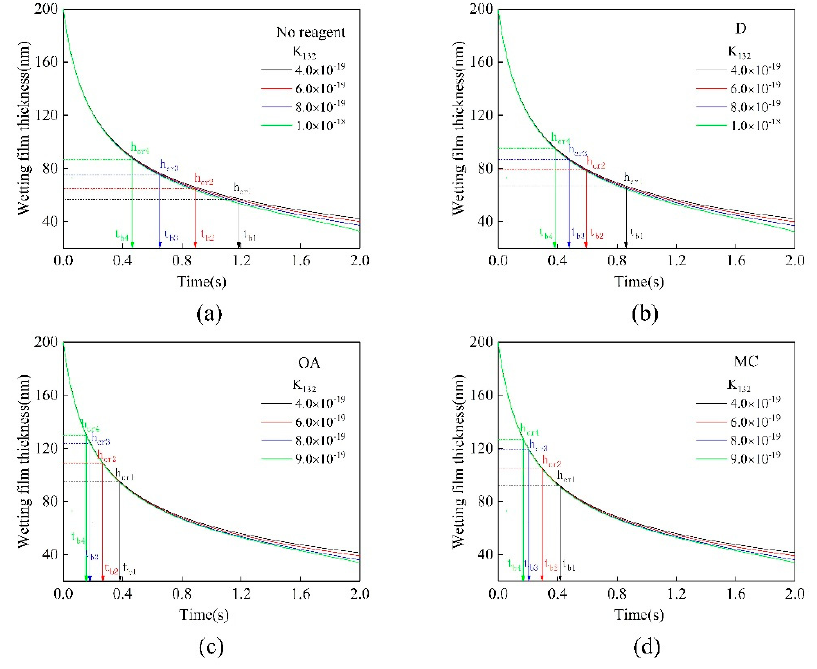
Figure 6. Wetting film thickness as the function of time in the condition of coal treated by ( a ) no reagent, ( b ) n-dodecane, ( c ) oleic acid, and ( d ) mixed collector.